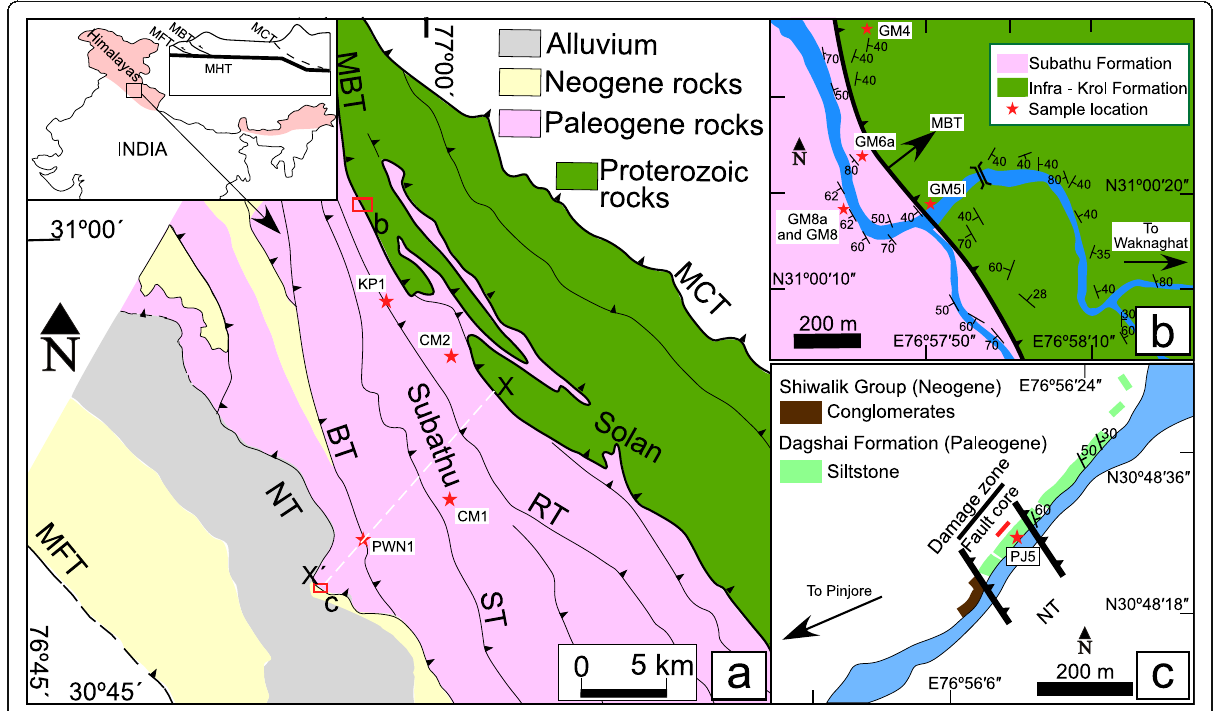
Fig. 1 a Large-scale map of the north-western Himalayas modified after Saha et al. (2016). Inset show the locality and simplified schematic cross section of Himalayas after Bose et al. (2009). MHT Main Himalayan Thrust, MCT Main Central Thrust, MBT Main Boundary Thrust, RT Ranon Thrust, ST Surajpur Thrust, BT Bilaspur Thrust, NT Nahan Thrust, MFT Main Frontal Thrust. The sample localities are indicated by red star. The red rectangles are shown as enlarged areas in ( b ) and ( c ). The X ′– X line represents the transect between NT and MBT along which the schematic structural section and depth-temperature data have been presented in Fig. 7. b Map of MBT at Gambarpul with sample location and bedding data. c Map of NT with lithological variation, sample location and bedding data. (GPS data of the samples are presented in Supplementary Table